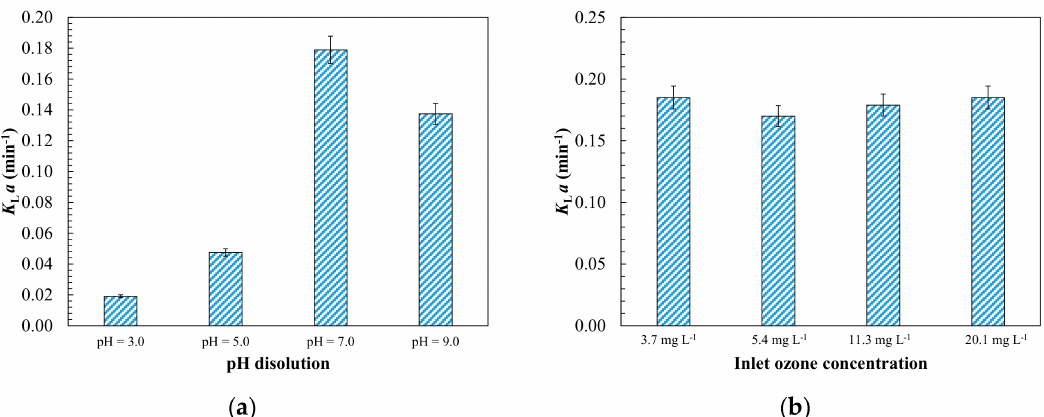
Figure 2. Comparison of volumetric mass transfer coe ffi cient: ( a ) influence of pH on K L a 1 and ( b ) e ff ect of inlet ozone concentration on K L a 2 . Experimental conditions: Q G = 4 L min − 1 ; M CAT = 3.3 g L − 1 ; T = 18.0 ◦ C; P = 1 atm; V reac = 1.5 L; ( Agitation ) = 60 rpm. 1 C O